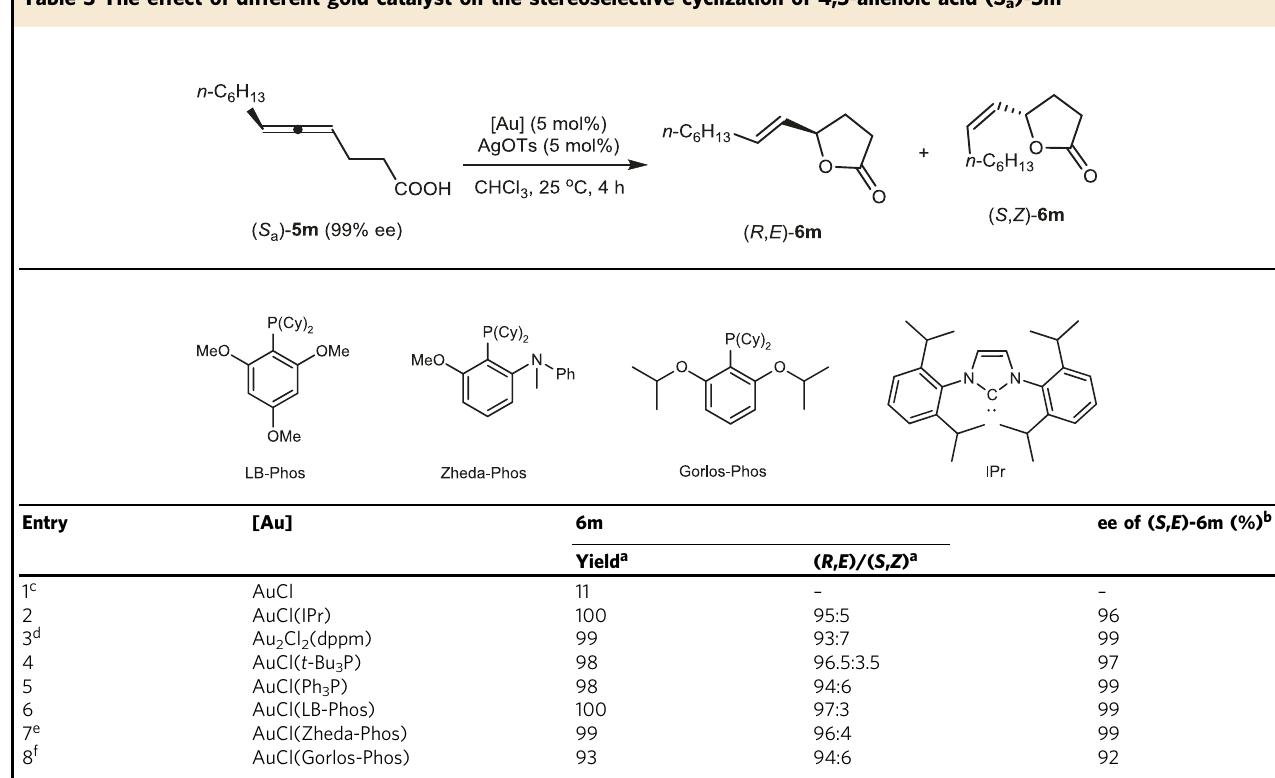
Table 3 The effect of different gold catalyst on the stereoselective cyclization of 4,5-allenoic acid ( S a